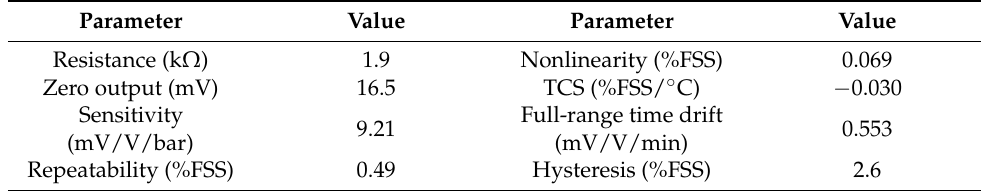
Figure 8. ( a ) Output voltage of the sensor; ( b ) forward and reverse step pressure test; ( c ) diagram of the output of sensor chip at full-scale pressure. Table 3. Technical data of the sensor at room